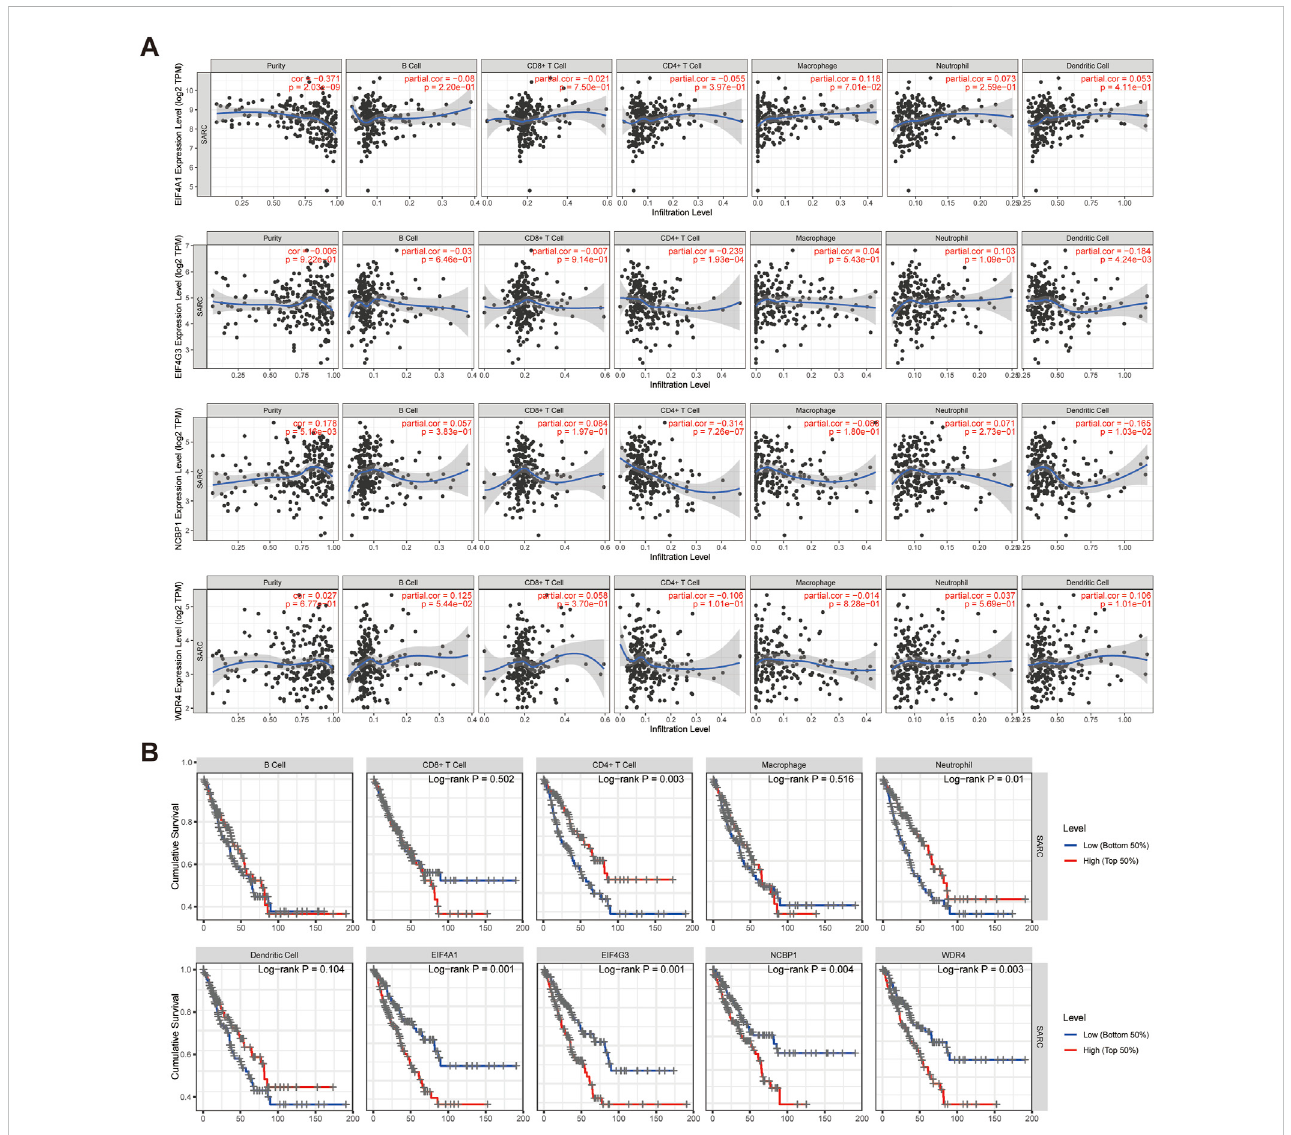
FIGURE 9 Prognostic m7GRGs intervene in immune in fi ltration in sarcomas. (A) Correlation between the abundance of immune cells and the expression of prognostic m7GRGs in sarcomas; (B) The relationship between the expression of EIF4A1, EIF4G3, NCBP1, WDR4, B cells, CD8 + T cells, CD4 + T cells, macrophages, neutrophils, dendritic cells and the cumulative survival rate in